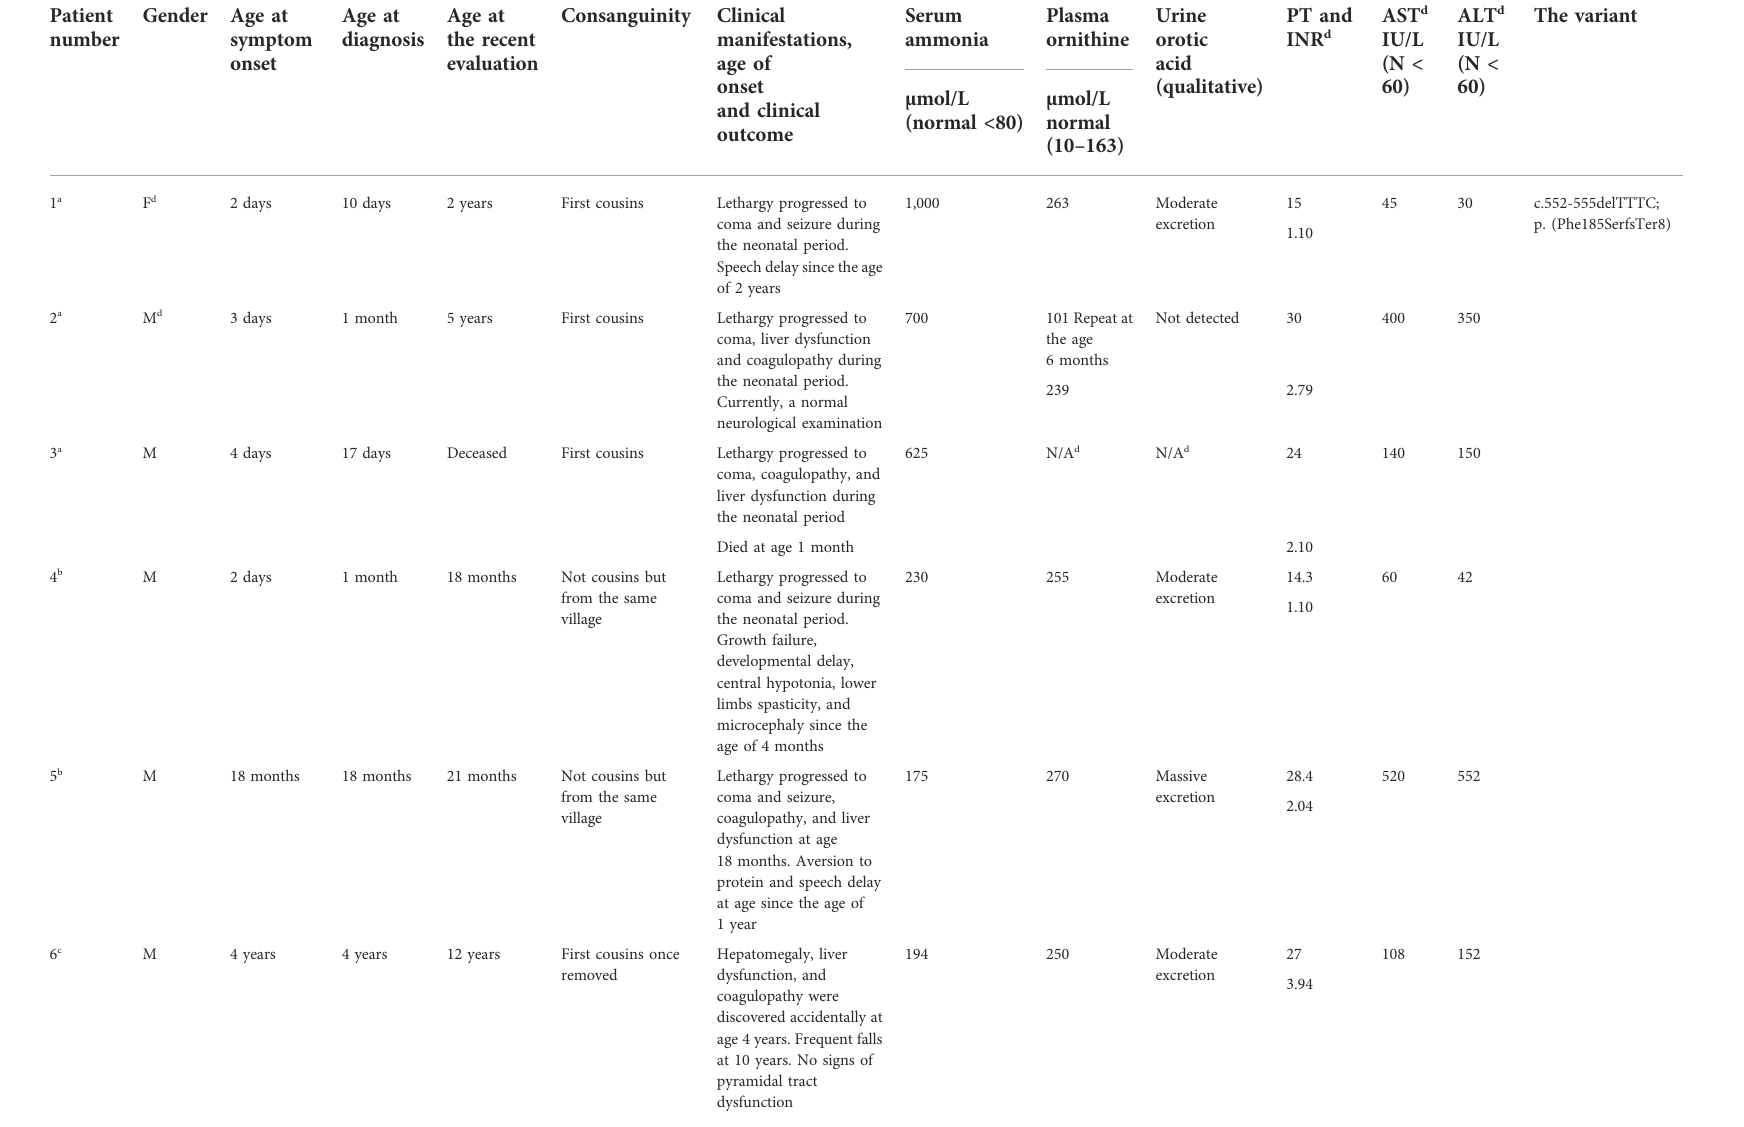
TABLE 1 Clinical phenotype, biochemical fi ndings, and genotype of patients with HHH syndrome. Patient Gender Age at number